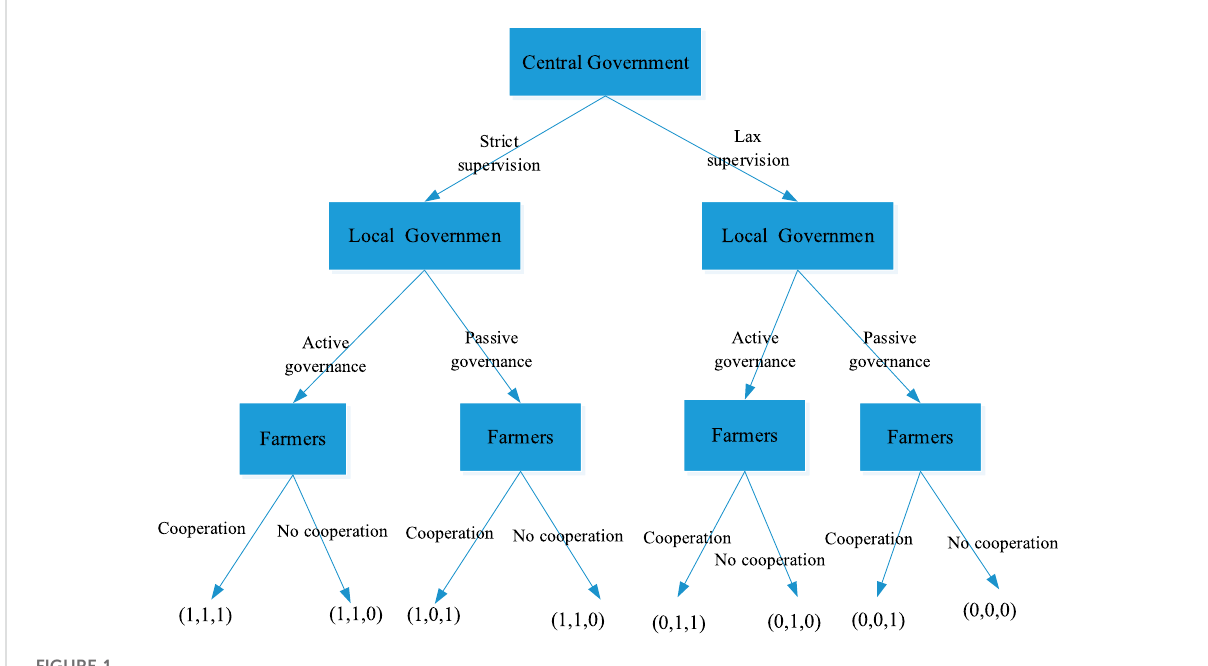
FIGURE 1 Multi-agent expected game model of clean heating